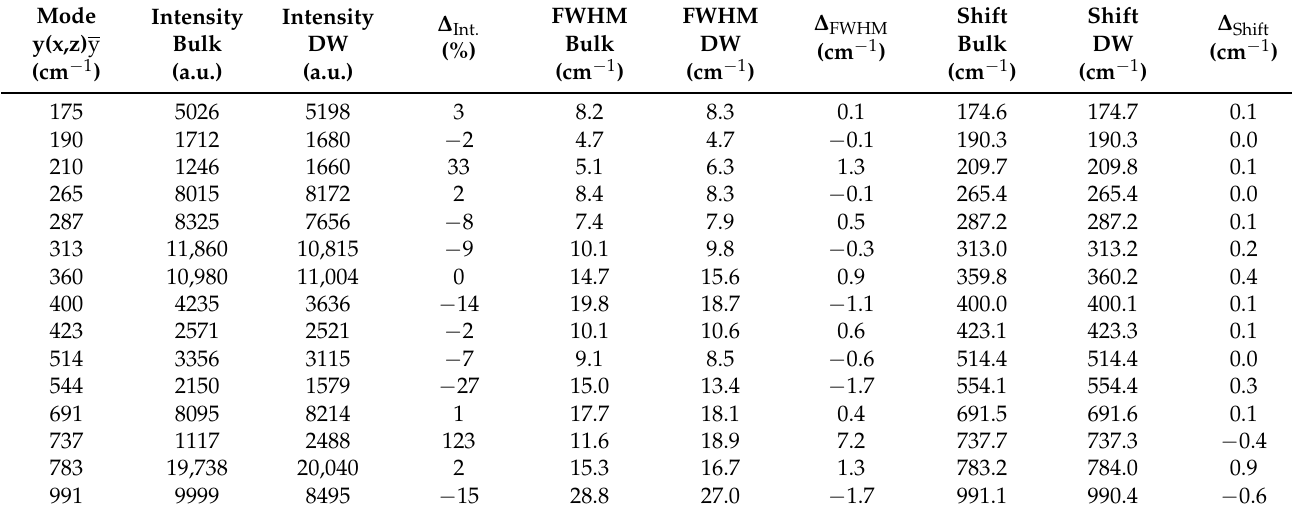
Table 1. Comparison of the intensity, FWHM and Raman shift of the peak frequency of the measured spectra in y(x,z)y scattering geometry of bulk KTP and a KTP DW. Positive change indicates, respectively, a gained intensity, FWHM or shift to higher frequencies, whereas a negative value indicates a lowered intensity, FWHM or a shift to lower